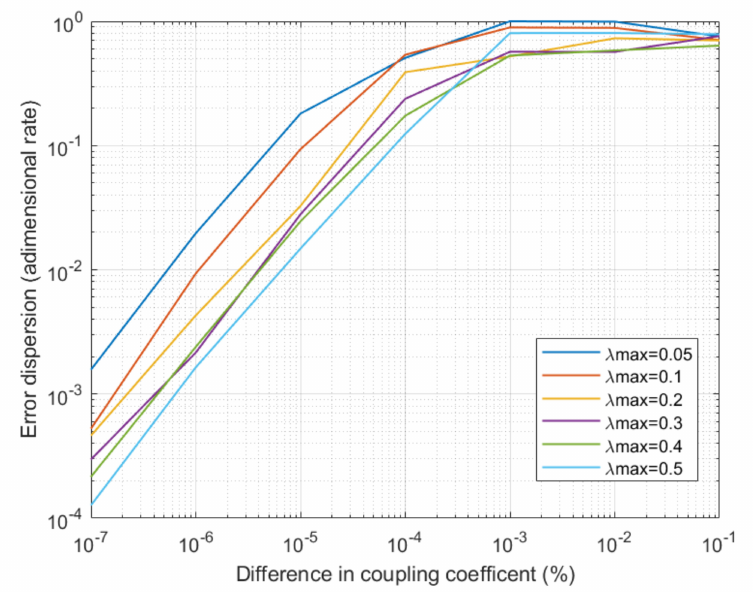
Figure 10. Evolution of error dispersion for di ff erent system